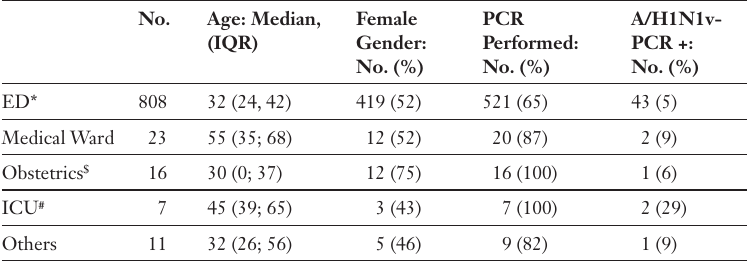
Table 4 A/H1N1v-PCR-Positive Patients in the University Hospital of